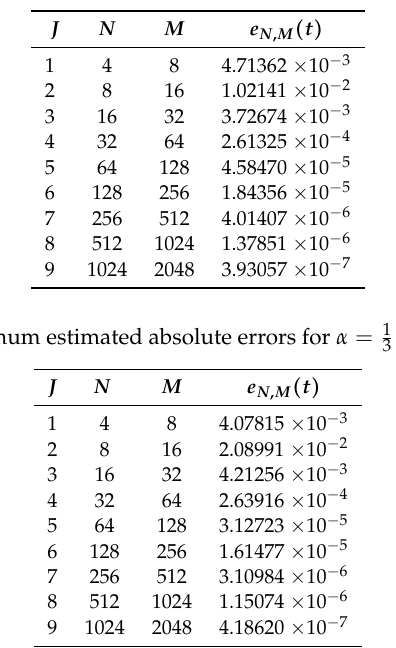
for Example 1. 2